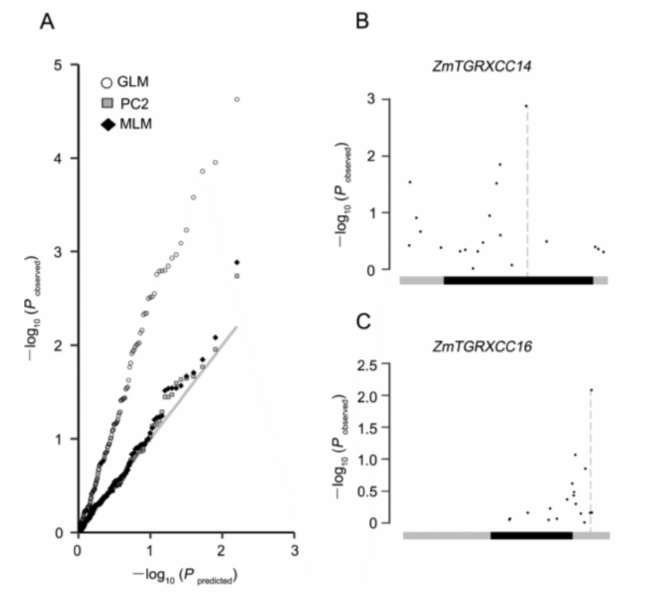
Figure 6. Association analysis of genetic variations in ZmGRXCC14 and ZmGRXCC16 with maize drought tolerance. ( A ), Quantile-quantile plots of estimated − log10( P ) from ZmGRXCC gene family-based association analysis using three methods. The gray line is the expected line under the null distribution. The white square represents the observed p values using GLM; the gray square represents the GLM model with the first two principal components (PC2); the black diamond represents the observed p values using the MLM model incorporating both PC2 and a Kinship matrix. Schematic diagrams of ZmGRXCC14 ( B ) and ZmGRXCC16 ( C ), including protein coding regions (thick black line), are presented in the x-axis. The p value is shown on a − log10 scale.